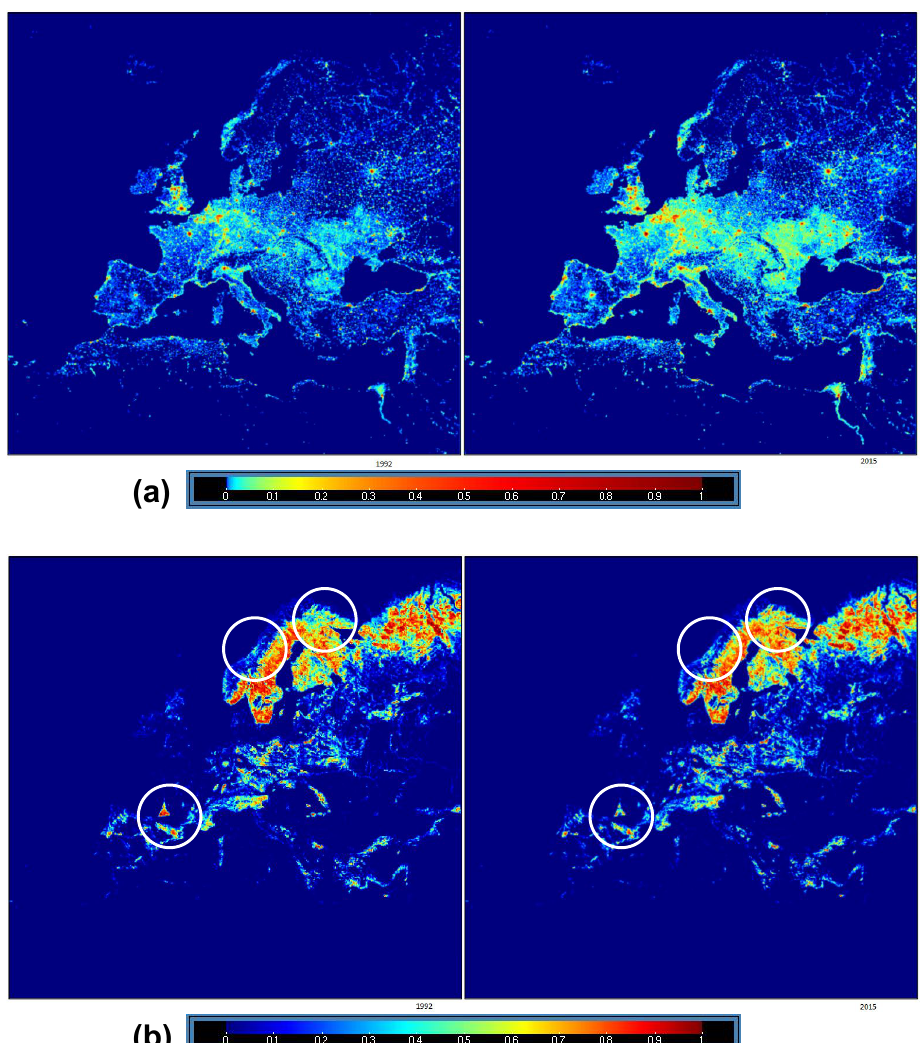
Figure 1. ( a ) Urban and Built-Up LC in 1992 ( left ) and 2015 ( right ), ( b ) Evergreen Needleleaf Forest LC in 1992 ( left ) and 2015 ( right ). White circles point at the regions with the biggest changes in